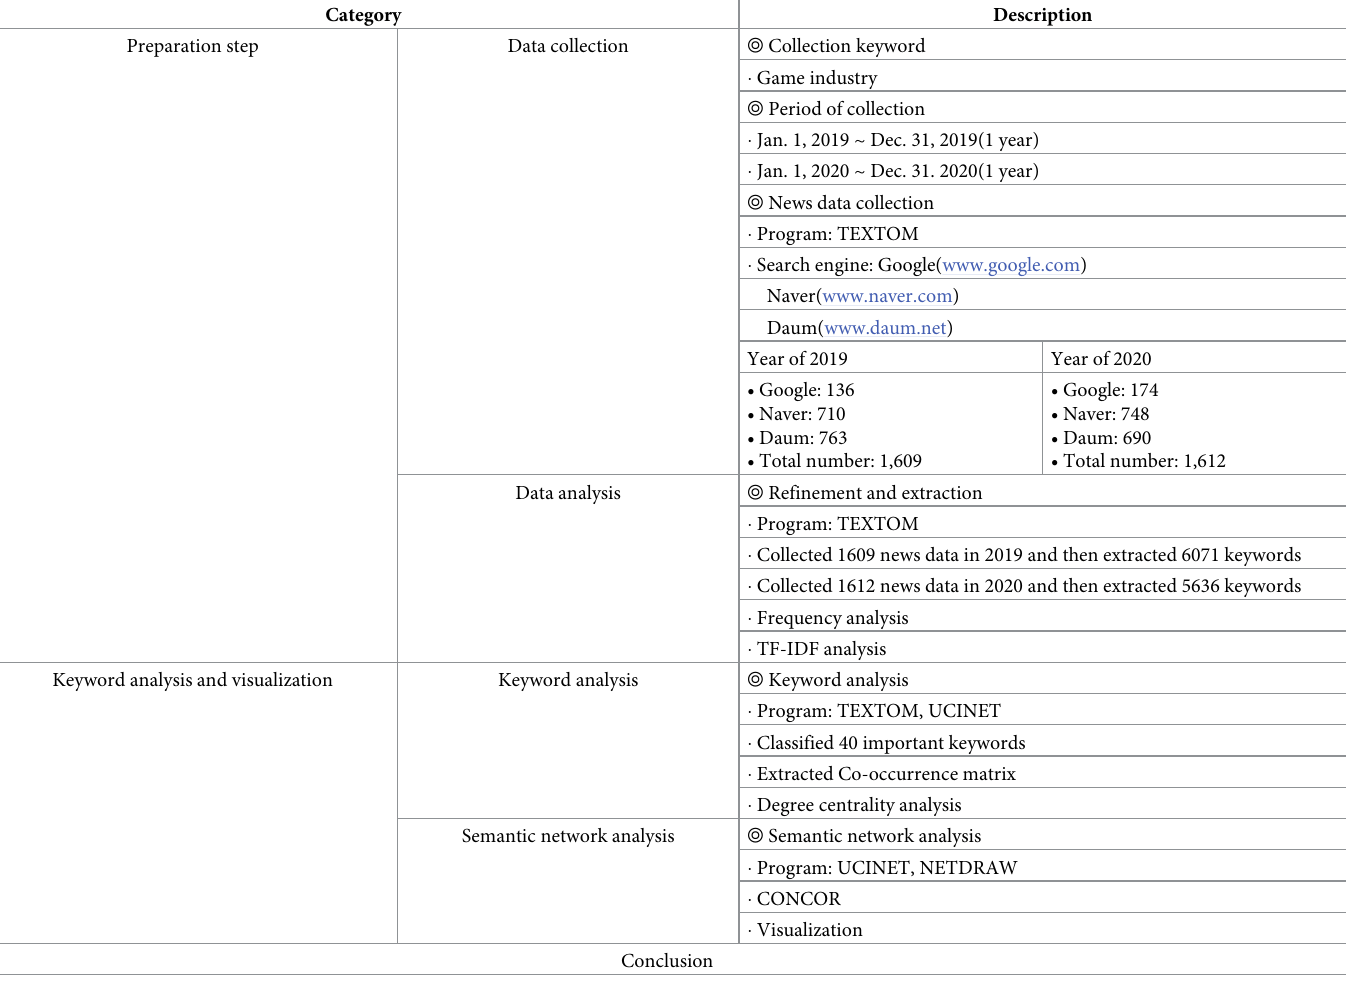
Table 1. The methodology processes and their